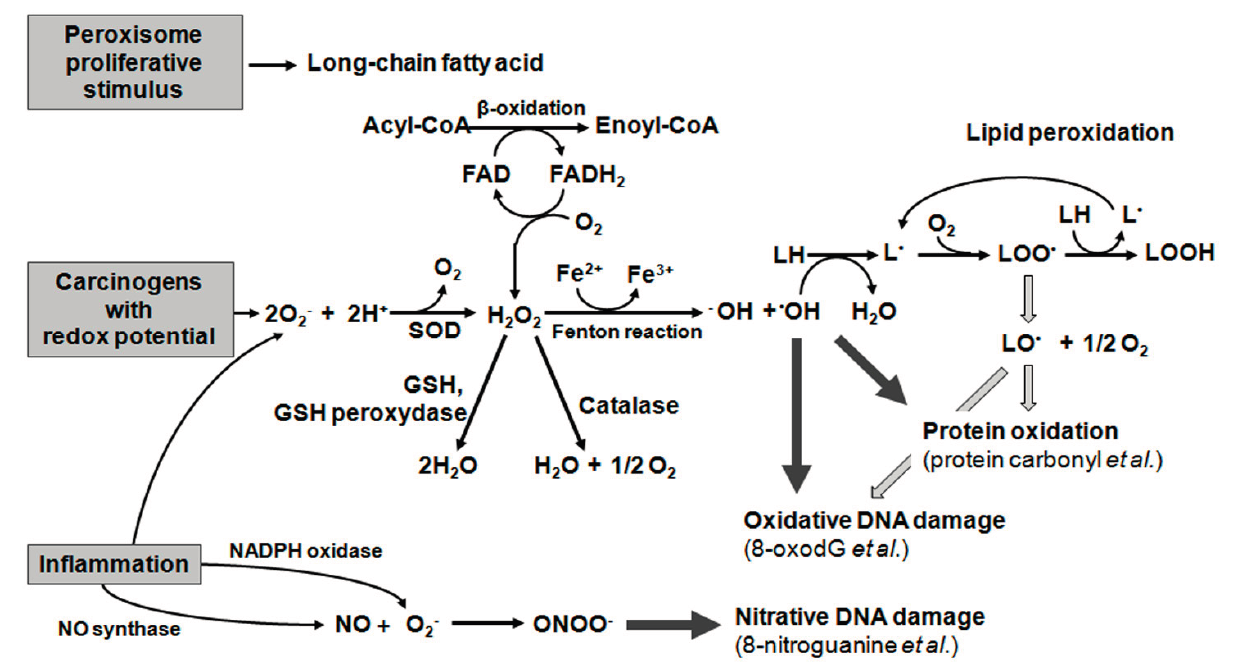
Figure 2. Oxidative damage to